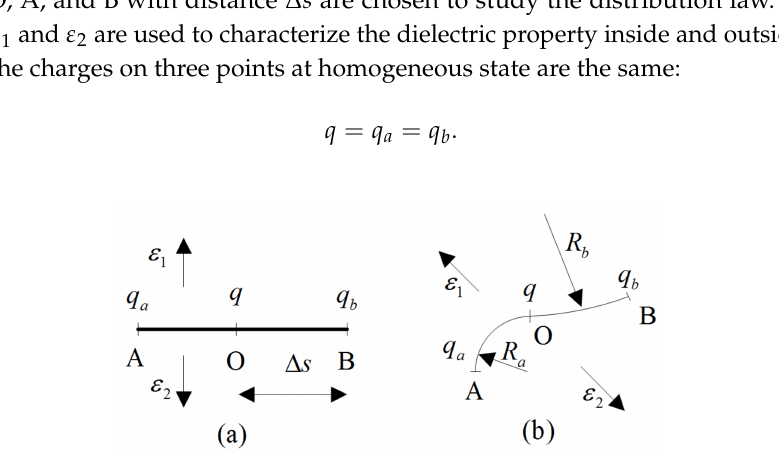
Figure 5. Distribution of charges on the outer surface of material: ( a ) homogeneous; ( b )